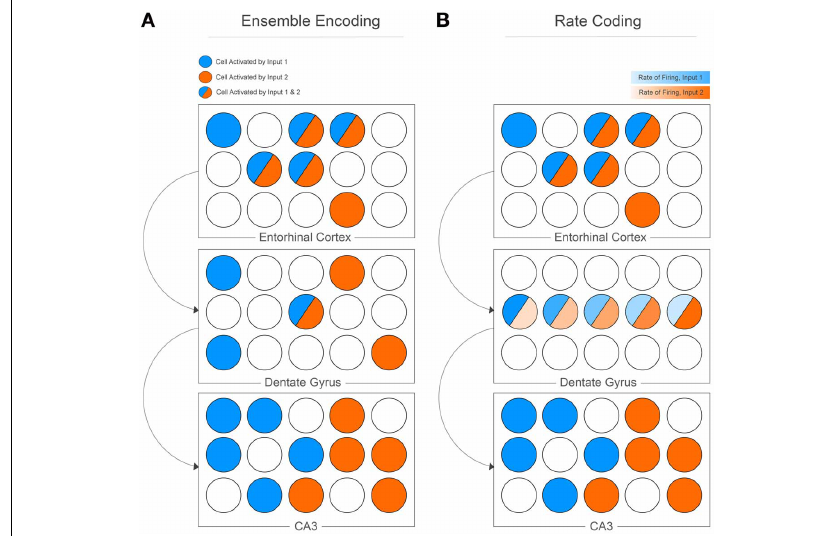
FIGURE 1 | Pattern separation was originally proposed as orthogonalization manifested at the cell population level (A). Cell population activity in the EC highly overlaps, but sparse activation of the DG and low contact probability of mossy fibers to CA3 cells manifests as unique cell ensemble activity for two separate input patterns. The DG can potentially encode information using rate coding (B) , whereby the same cells are active for separate inputs, but the rate of firing for each cell differs between inputs. The CA3 then decodes these rates to produce unique cell ensemble